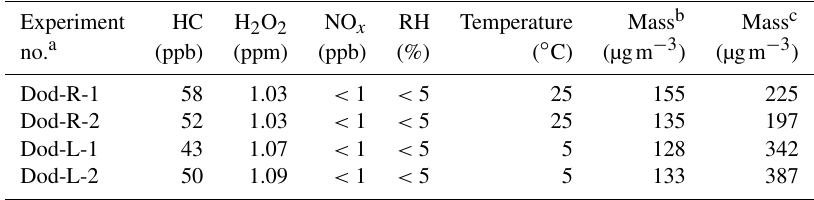
Table 1. The initial conditions of the smog chamber experiments. Experiment HC H 2 O 2 NO x RH Temperature Mass b Mass c no. a (ppb) (ppm) (ppb) (%) ( ◦ C) (µgm − 3 ) (µgm − 3 ) Dod-R-1 58 1.03 < 1 < 5 Dod-R-2 Dod-L-1 Dod-L-2 50 1.09 < 1 < 5 133